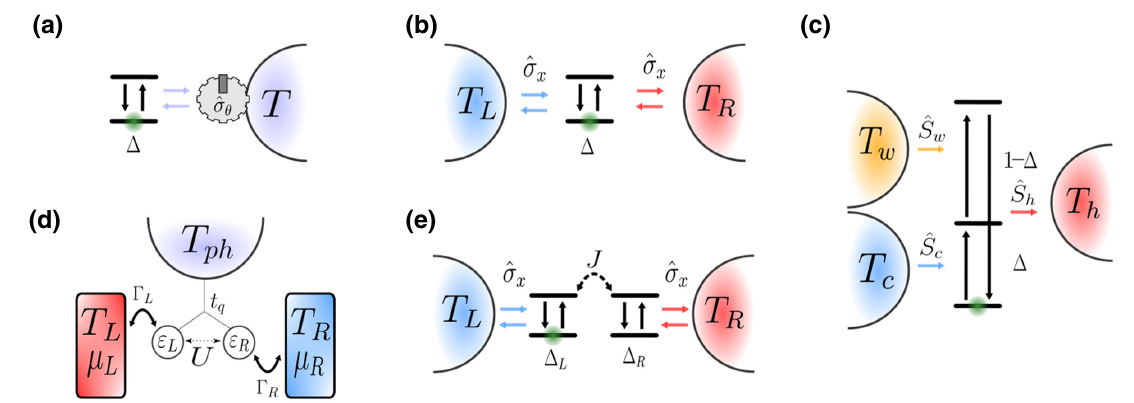
FIG. 1. Diagrams of the five problems examined in this work using the RCPT method. (a) Quantum thermalization , studied with a two-level impurity spin coupled to a bosonic reservoir experiencing both decohering and energy-exchange effects. (b) Quantum heat transport , examined on a minimal model of a spin system coupled to two bosonic reservoirs with a temperature bias. (c) Quantum refrigeration , examined on a three-level quantum absorption refrigerator, where each transition couples to a different reservoir, resulting in the net effect of extracting heat from the cold environment. (d) Thermoelectric performance of nanojunctions , illustrated on a phonon-assisted double-quantum-dot nanojunction. Here, charge is transported between the two leads with the help of a phonon environment. (e) Dissipative spin chains , with each spin coupled to an independent heat bath, here illustrated with a two-qubit